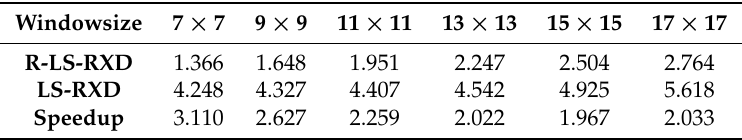
Table 6. Computing Time